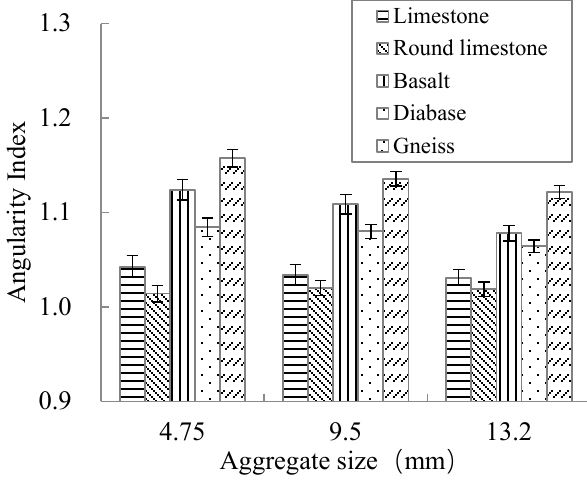
Figure 6. Test results of aggregate angularity index.